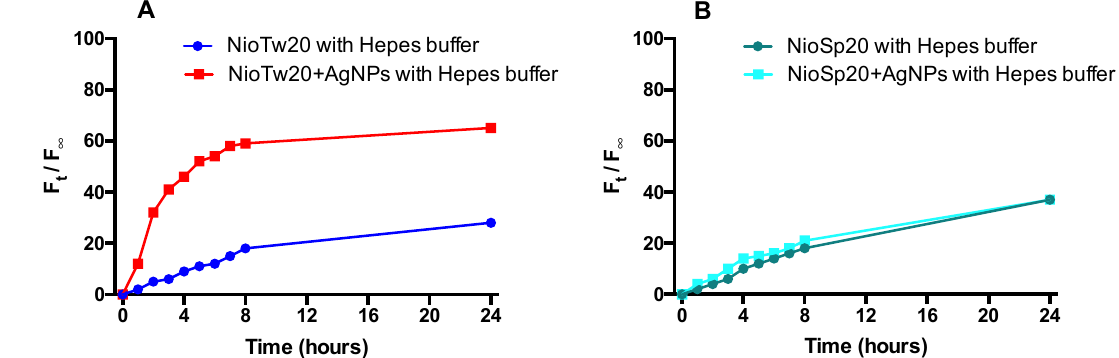
Figure 6. Calcein release studies in HEPES buffer at 37 °C from: ( A ) NioTw20/AgNPs; ( B ) NioSp20/AgNPs.